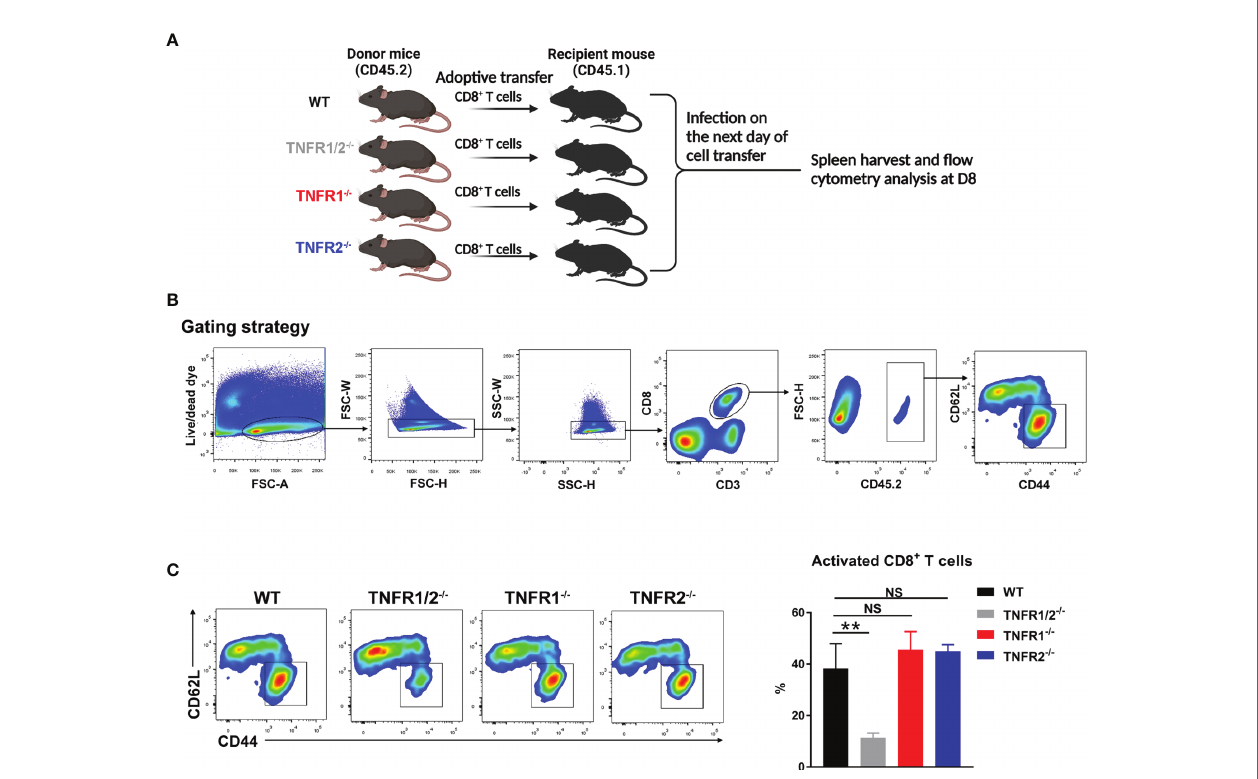
FIGURE 9 | Intrinsic role of TNFRs in CD8 T cell activation. (A) CD8 + T cells were puri fi ed from the spleens of WT, TNFR1/2 -/- , TNFR1 -/- and TNFR2 -/- mice by using MACS beads, followed by adoptively transferring into CD45.1 mice (2 ×10 6 CD8 + T cells/mouse, 3 mice/group) at one day prior to infection. Mice were infected, as in Figure 7 , and splenocytes were harvested at D8. (B) Flow cytometric gating strategy. Live and single spleen cells were gated fi rst, followed by the gating of CD3 + CD8 + T cells. The adoptively transferred CD8 + T cells from donor mice were identi fi ed by CD45.2 + populations. The donor cells were further analyzed for CD44 and CD62L, respectively. (C) The represented fl ow cytometry images and the percentages of CD8 + T cell activation (CD44 + CD62L - ) were presented. Data are shown as mean ± SD from single experiments and are representative of at two experiments performed. A one-way ANOVA with a Tukey ’ s multiple comparisons test was used for statistical analysis. ** p <0.01; NS, not signi fi